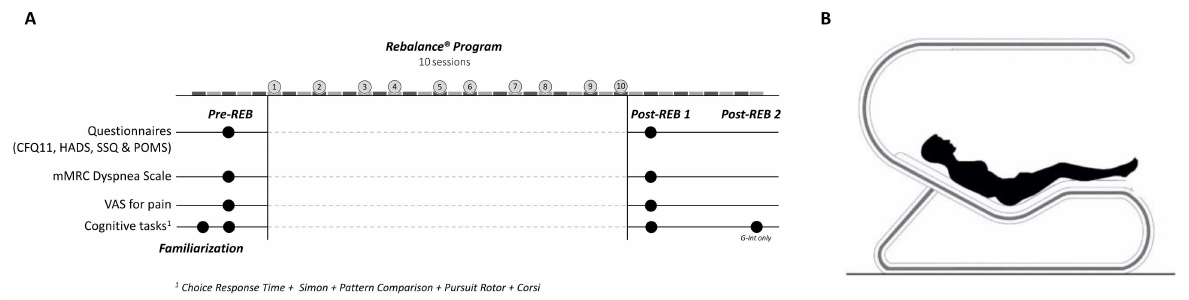
Figure 1. ( A ) Experimental design. ( B ) Schematic representation of the Rebalance ®